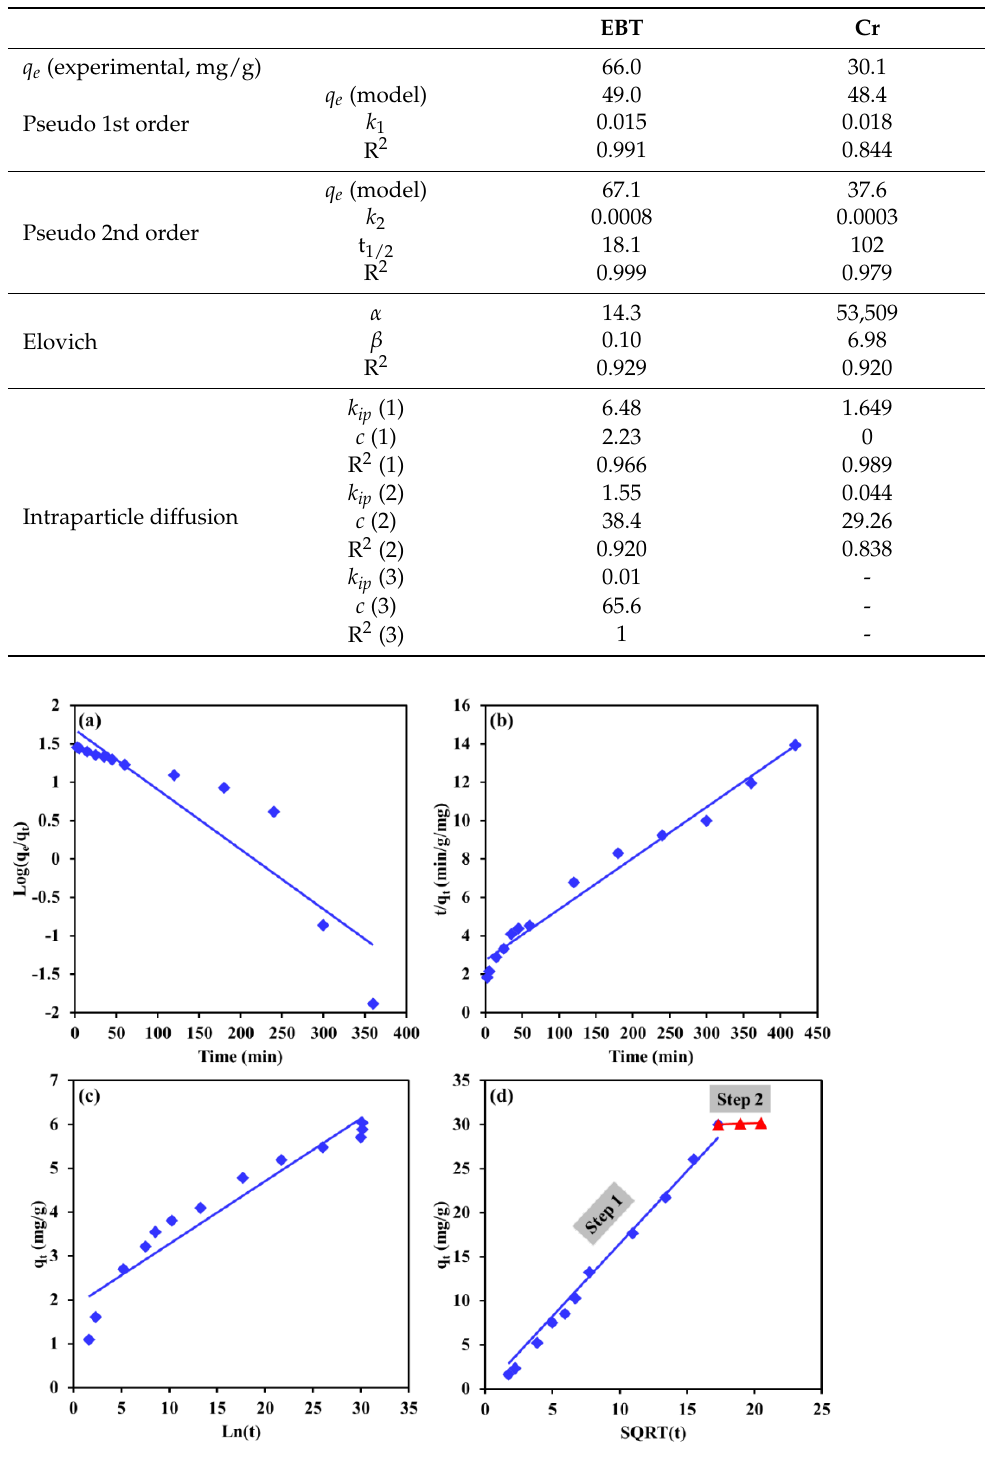
Table 2. Parameters and correlation factors of the tested Kinetic models on EBT and Cr removal by calcinated Mg-Ca-Al-LDO composite.